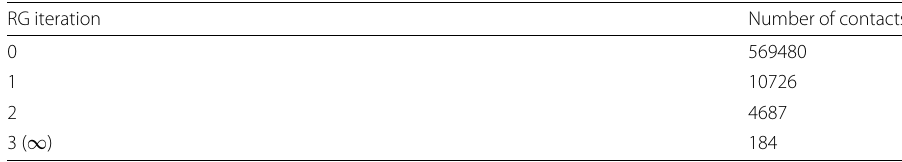
Table 2 Reduction of data similar to that described in “Data reduction and anomaly detection” section under RG